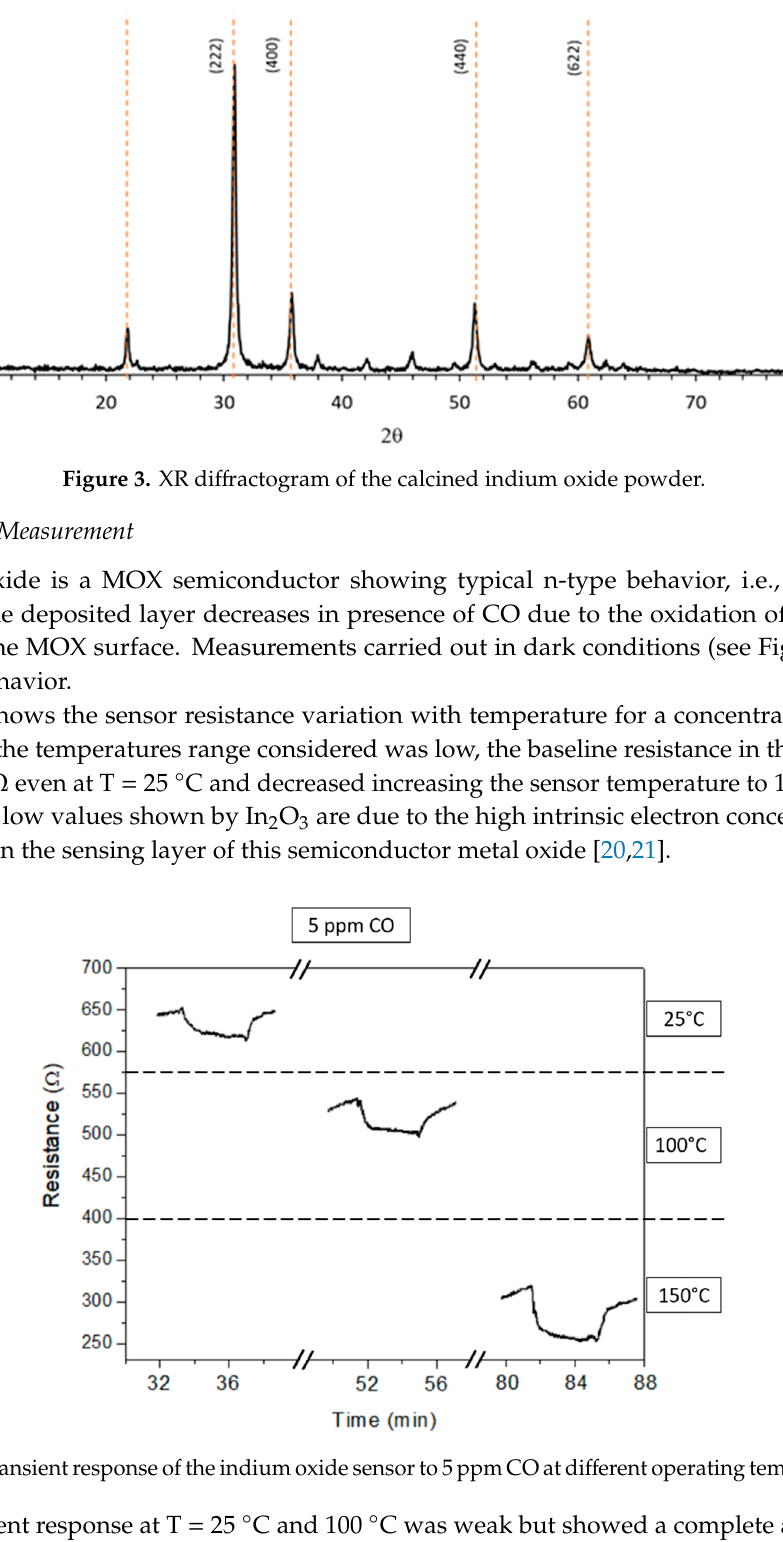
Figure 4. Transient response of the indium oxide sensor to 5 ppm CO at different operating temperatures.